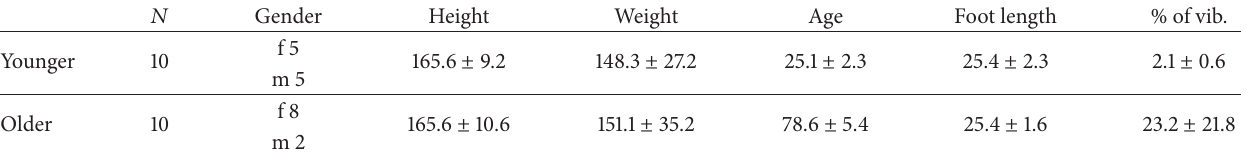
Table 1: Anthropometric characteristics and foot sole vibration threshold of younger and older